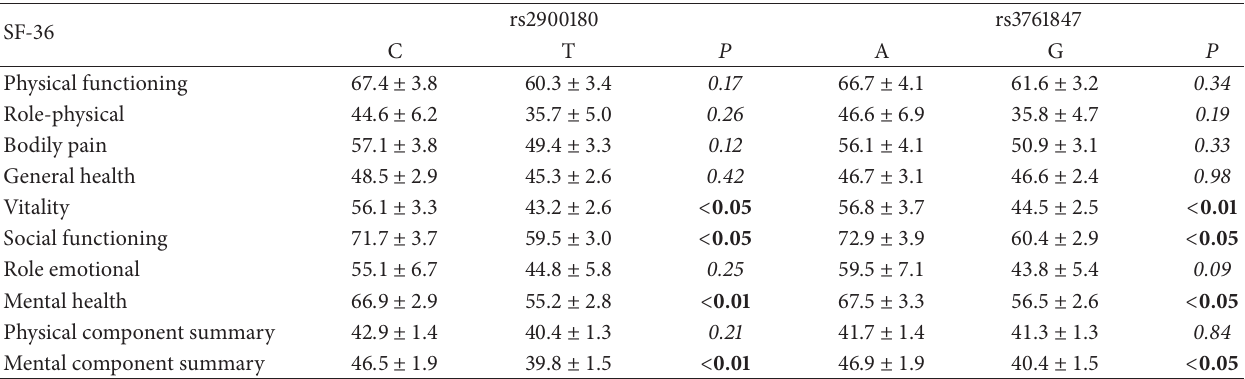
Table 5: Allelic analysis (C versus T and A versus G) of rs 2900180 and rs 3761847, respectively, in relation to SF-36 domains.